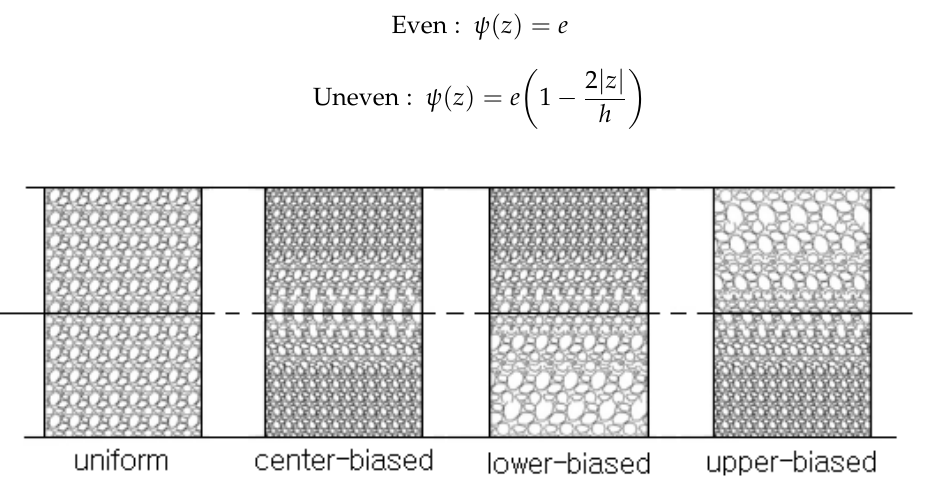
Figure 2. Uniform, center-, lower-, upper-biased porosity distributions [12]. Second, referring to a paper by Kim et al. [19], the porosity ψ ( z ) in sym, unsym-1 and unsym-2 distributions is expressed by